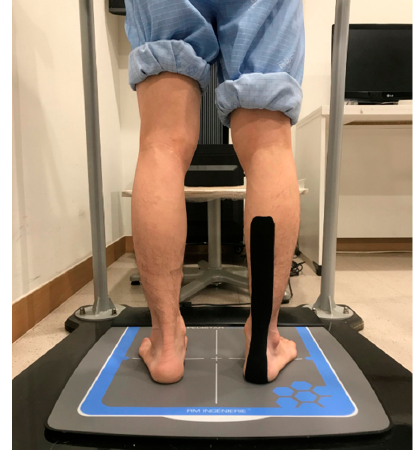
Figure 2. Calf muscle